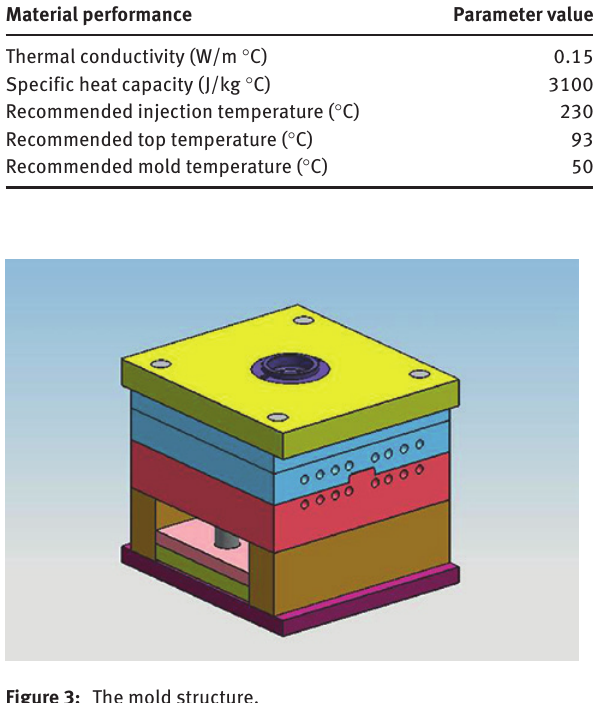
Figure 3: The mold structure.